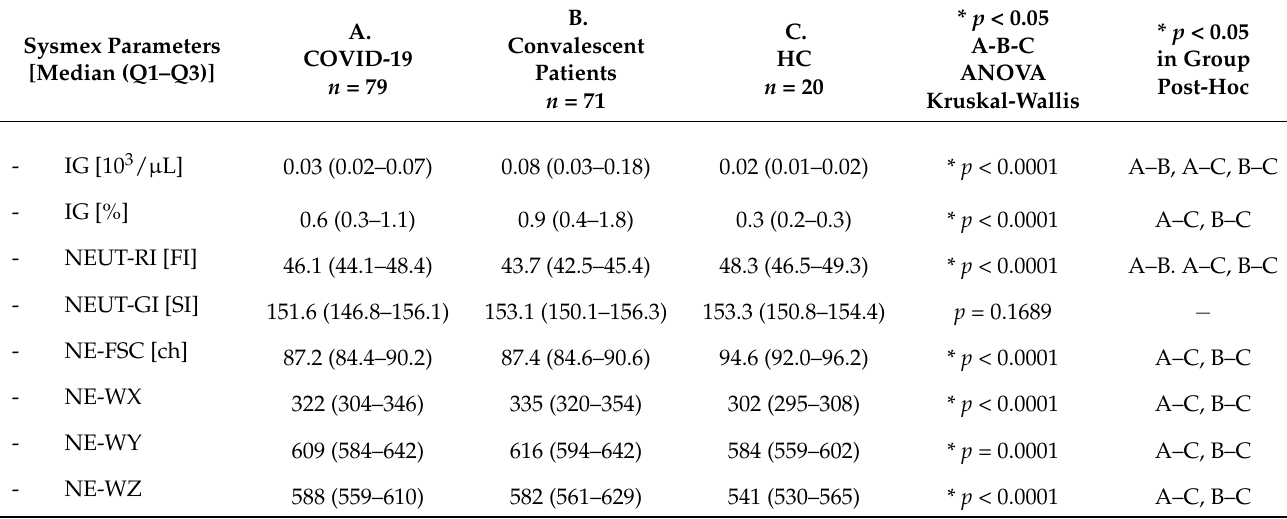
Table 4. Proportion of Sysmex parameters connected with neutrophils in patients: with COVID-19 A, convalescent patients with COVID-19 B, and control group (HC) C. Data expressed as median (Q1–Q3). * p indicates statistically significant.